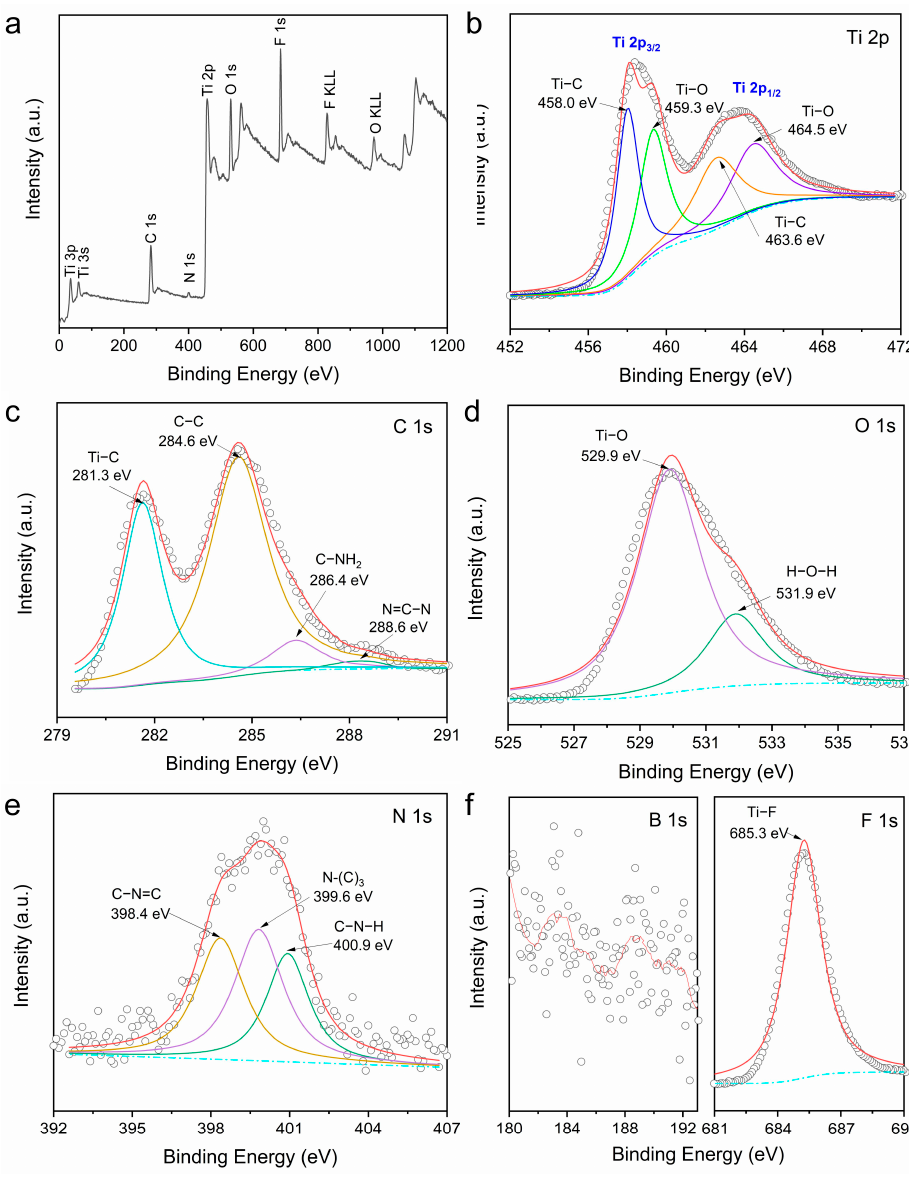
Figure 6. XPS spectra of 5TC-TBCN: ( a ) survey; ( b )Ti 2p; ( c ) C 1s; ( d ) N 1s.; ( e ) O 1s; ( f ) B 1s and F 1s.